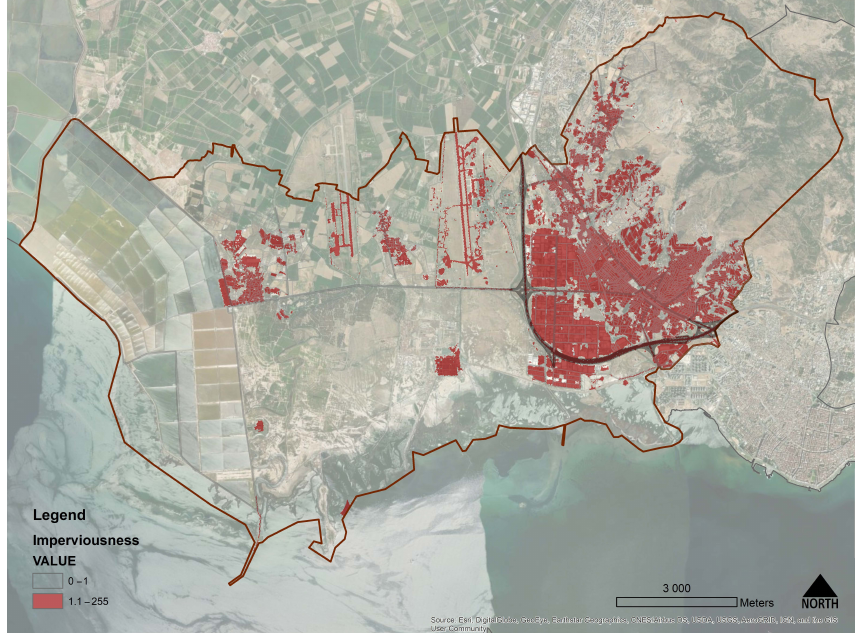
Figure 4. High-Resolution Imperviousness Degree on Çi ğ li district (source: author’s elaboration). Table 2. Statistics of the Imperviousness and Tree Cover Density degree datasets.